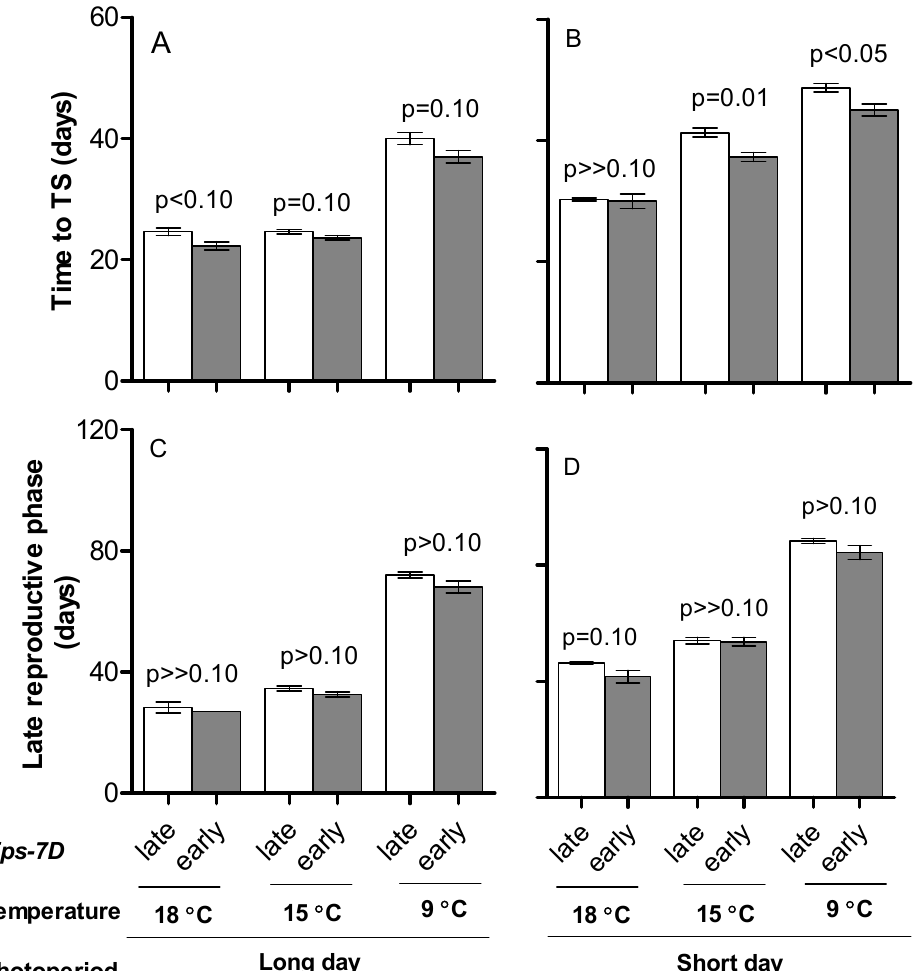
Figure 2. Duration of phase from seedling emergence to TS ( A , B ) and time from then to anthesis, late reproductive phase ( C , D ) for the lines carrying Eps-7D - late (open bars) or early (closed bar) on Ppd-D1a background under long ( A , C ) and short days ( B , D ) at three temperatures. Error bars indicate the SEMs and the “ p ” values stand for the level of significance exclusively due to the action of the Eps-7D gene within each temperature and photoperiod condition.